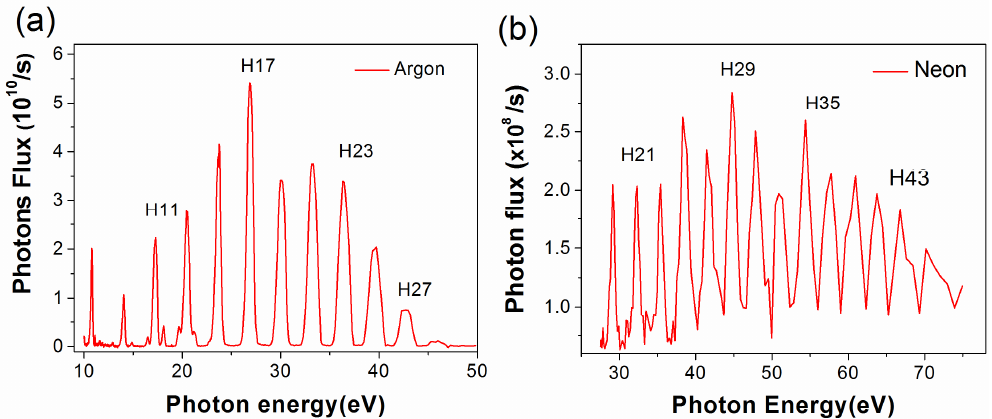
Figure 7. HHG spectra of ( a ) Ar and ( b ) Ne, generated with the fundamental TiS laser λ = 800 nm (1.55 eV). The absolute photons flux is measured after the monochromator slit. The HHG EUV spectra of Ar and Ne were also produced with 400-nm driving laser pulses [47]. The 1.2-mJ 400 nm pulses are obtained through second harmonic generation of fundamental laser